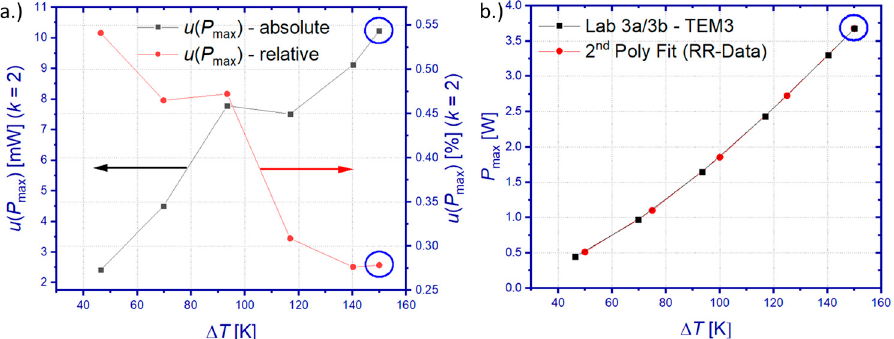
Figure 5. The absolute and relative uncertainty u ( P max ) ( k = 2) ( a ) and P max ( b ) are shown in dependence on Δ T . P max has been determined from a parabolic approximation of P ( I , t ) according to Equation (19), while u ( P max ) was determined from Equation (23). In order to achieve comparability of RR results, DLR data were interpolated for Δ T = 50, 75, 100, and 125 K and extrapolated for Δ T = 150 K. A linear fit was used for u ( P max ), whereas P max has been approximated by a parabolic fit. Extrapolated values are indicated by blue circles.